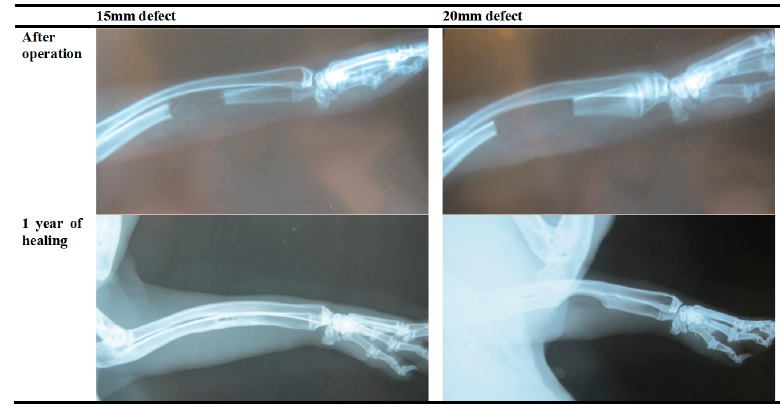
Figure 9. Segmental defect created on NZW rabbit after 1 year of healing.